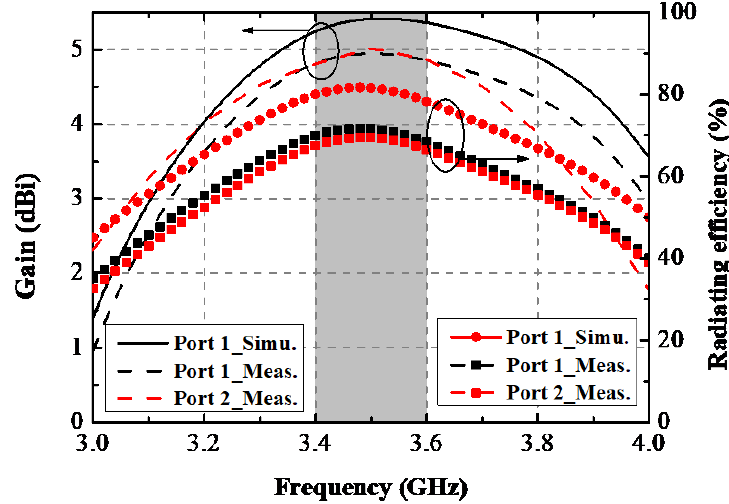
Figure 12. Measured and simulated S-parameters of the proposed AP system.